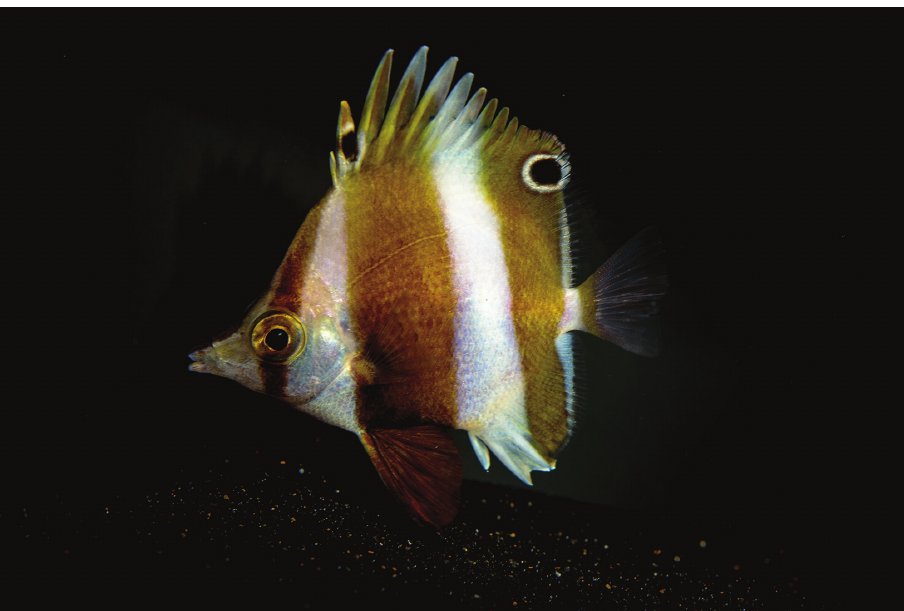
Figure 2. Live specimen of Roa rumsfeldi sp. n. photographed at the California Academy of Sciences’ Twilight Zone exhibit (photo LA